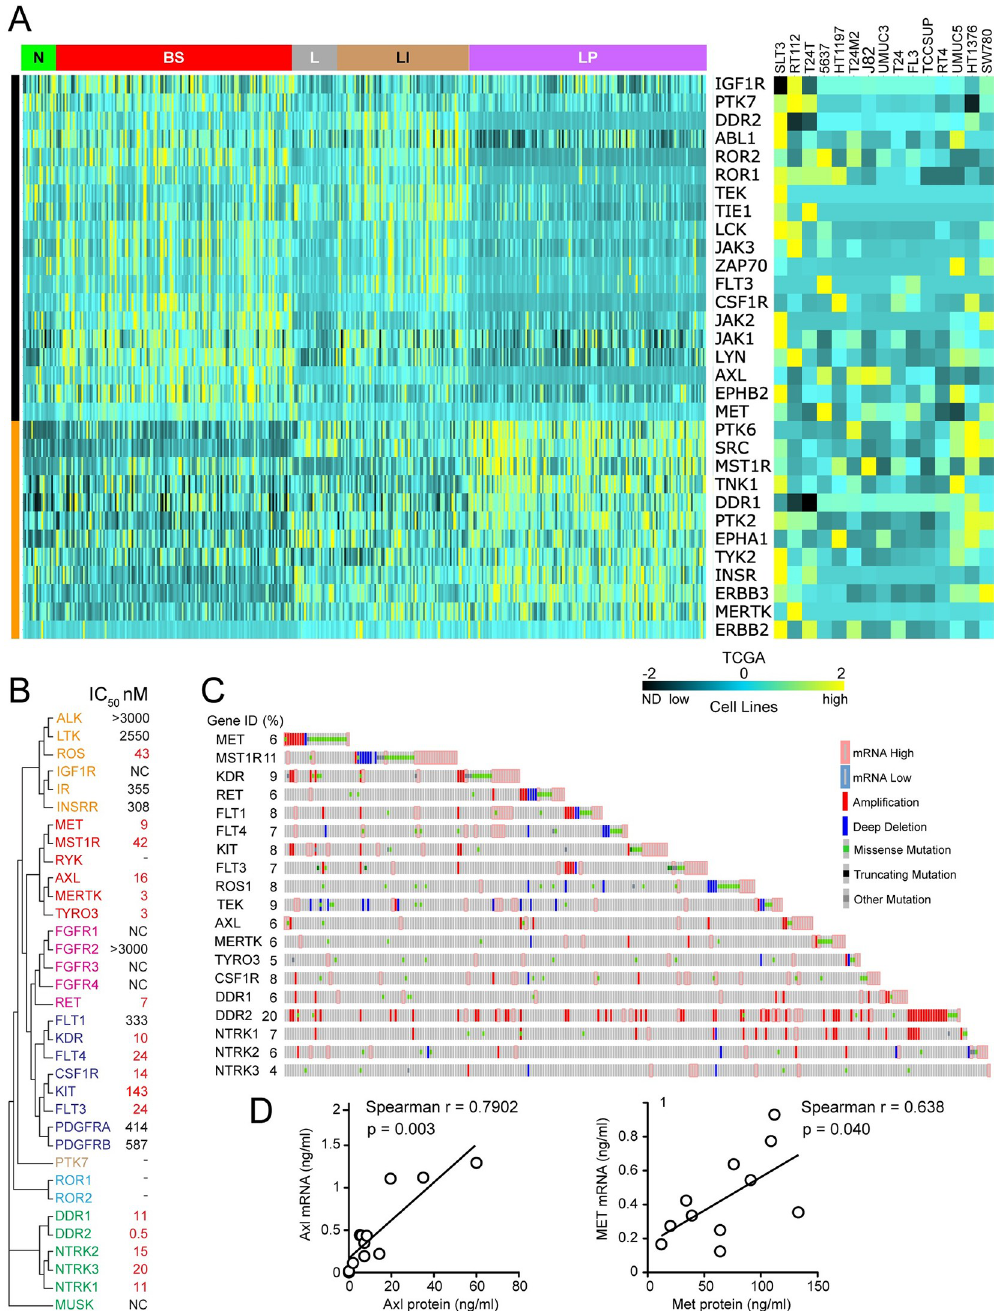
Fig 3. TK expression in MIBC patient tumor samples and BCa cell lines. (A) Heat maps of relative mRNA expression levels in 408 tumor samples from patients with MIBC [22] (RNA Seq V2, left) and absolute mRNA copy number in 15 BCa cell lines (right) of 31 TKs (gene symbols listed vertically, middle). MIBC patient tumor samples are grouped on the horizontal axis by mRNA subtype classifications as previously defined [22] indicated at the top (from left to right): neuronal (N, green); basal squamous (BS, red); luminal (L, gray); luminal infiltrating (LI, gold); luminal papillary (LP, purple). TK genes are clustered hierarchically; colored vertical bars at indicate group 1 TKs (black) above group 2 TKs (orange). Highest expression is shown in yellow, moderate expression in blue and lowest expression in black; ND for cell line data indicates transcript was undetectable. (B) Cladogram of 34 receptor TKs (RTKs) most closely related to Met based on TK domain amino acid sequence identity, constructed using the EMBL-EBI ClustalW2 Phylogeny tool (http://www.ebi.ac.uk/Tools/ phylogeny/clustalw2_phylogeny). RTK symbol colors identify established subfamilies. Values for cabozantinib doses calculated to provide 50% TK inhibition (IC 50 , nM) in a cell-free assay, listed at right, were derived from a minimum of 3